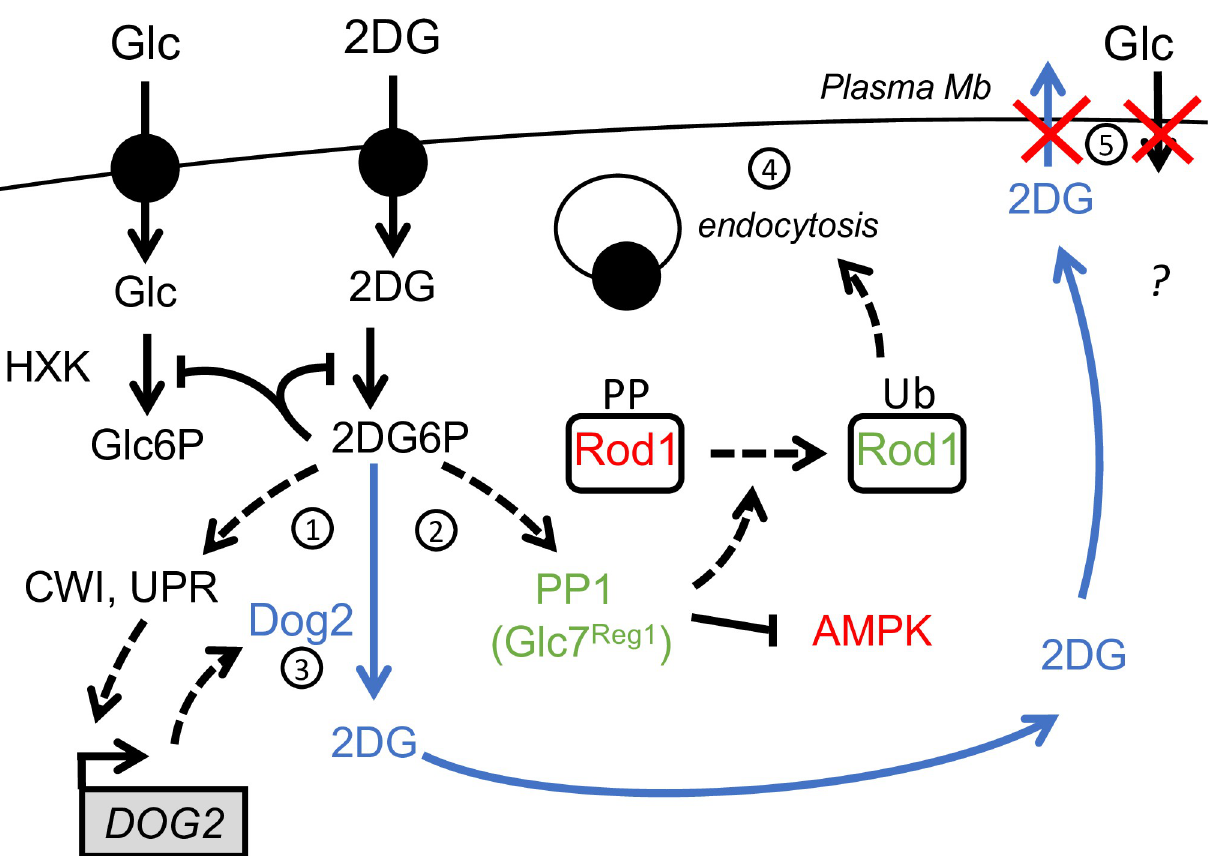
Fig 7. Hypothetical model for a role of hexose transporters in 2DG detoxification. Treatment of cells with 2DG triggers the accumulation of intracellular 2DG6P. This activates stress-signaling pathways such as cell-wall integrity signaling (CWI) or the unfolded protein response (UPR), converging onto DOG2 expression (1) [20]. On the other hand, 2DG6P elicits a fast PP1 activation (2) which causes AMPK inhibition and, either directly or indirectly, Rod1 dephosphorylation. By the time Dog2 is induced and begins to dephosphorylate 2DG6P (3), Rod1 has already triggered the endocytosis of many plasma membrane proteins (4), including that of low affinity glucose transporters. This may prevent 2DG exit and detoxification but also affect cell survival by reducing glucose import